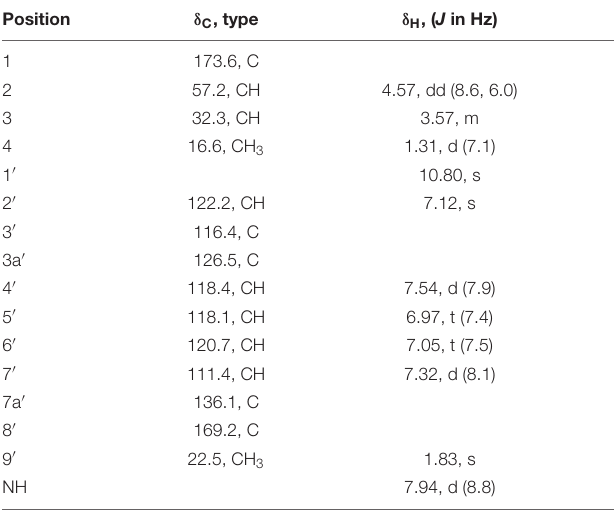
TABLE 5 | 1 H NMR (600 MHz) and 13 C NMR (150 MHz) data for 5 in DMSO- d 6 ( δ in ppm, J in